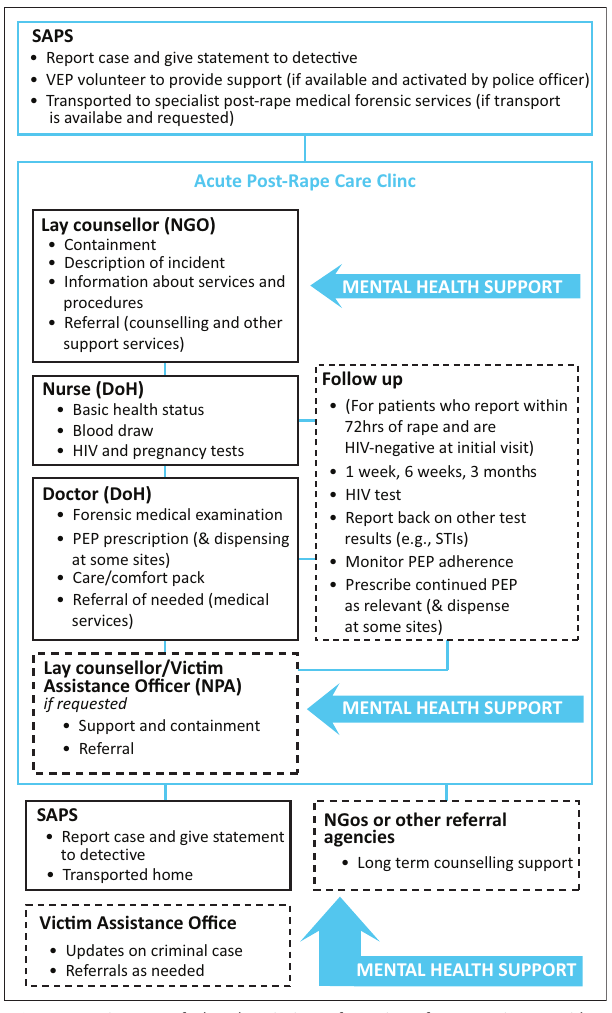
FIGURE 1: Diagram of the description of services from service providers interviewed and from